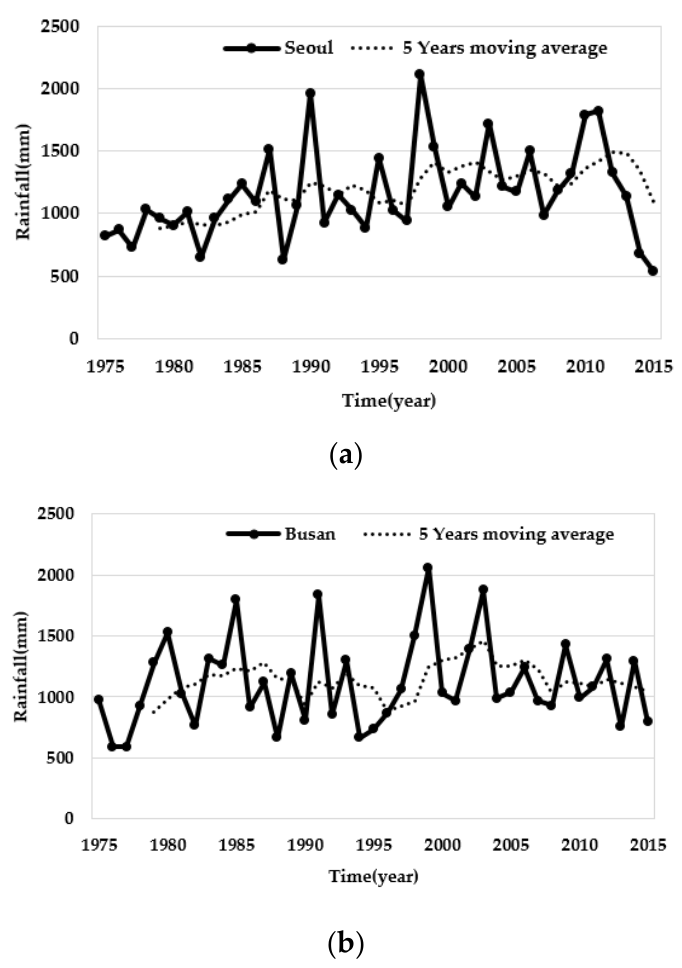
Figure 1. Annual rainfall during the rainy season (June–October) and moving average of meteorological stations in Seoul ( a ) and Busan ( b ).